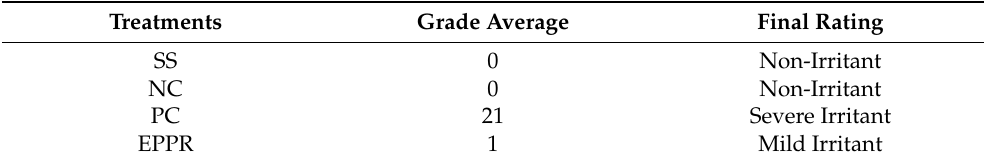
Table 5. Grade average and final ocular irritability rating of saline solution and gels. The numerical grading varies between 1, 3, 5, 7, and 9 depending on the team. Treatments Grade Average Final Rating SS 0 Non-Irritant NC 0 Non-Irritant PC 21 Severe Irritant EPPR 1 Mild Irritant Saline solution (SS, 0.9%), negative control (NC; base gel), positive control (PC; dexamethasone gel 1 mg/g), and EPPR (EPPR gel, 5